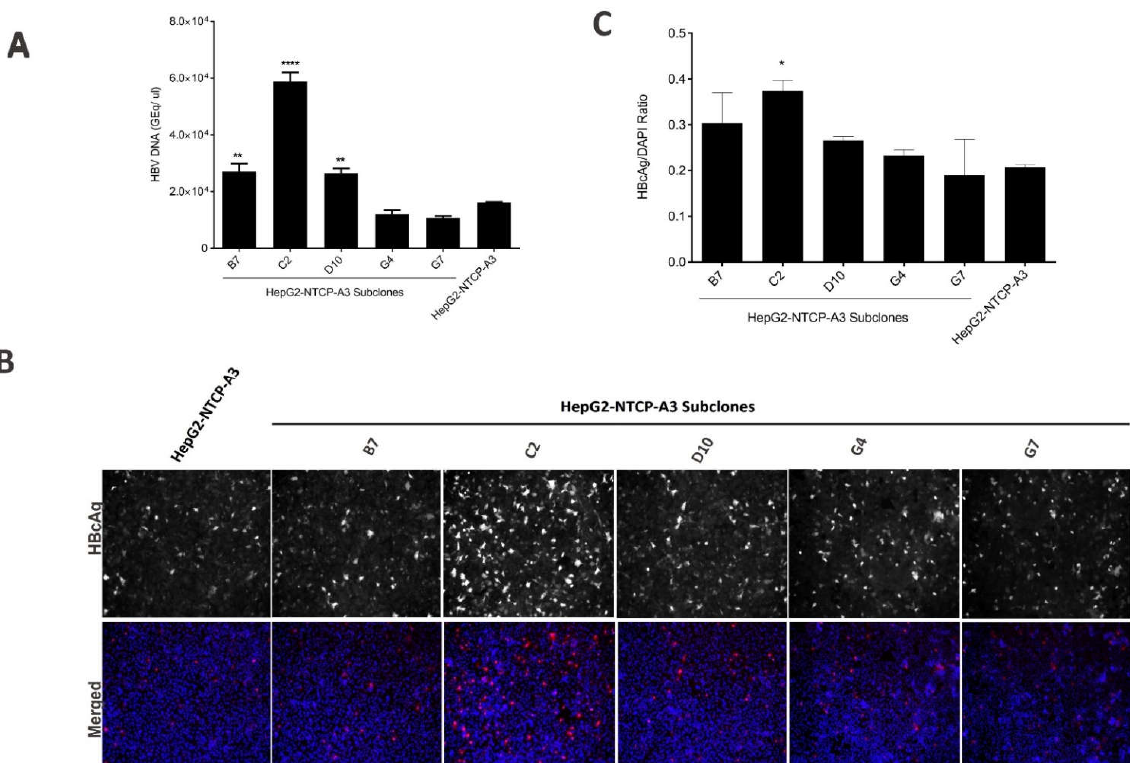
Figure 2. PEG-free HBV infection in HepG2-NTCP-A3 subclones. ( A ). Indicated subclones of HepG2-NTCP-A3 were infected with HBV in PEG-free conditions and the amount of HBV DNA in the cell culture supernatant was quantified by real-time qPCR; ( B ). PEG-free HBV infected cells were fixed and immunostained with HBcAg and counterstained with DAPI. The cells were visualized by fluorescence microscopy; ( C ). HBcAg fluorescence over DAPI shown as a ratio. Data are presented as mean ± SD (One way ANOVA; p < 0.0001, * level of significance). To determine if the enhanced permissiveness of C2 was limited to a single HBV gen-